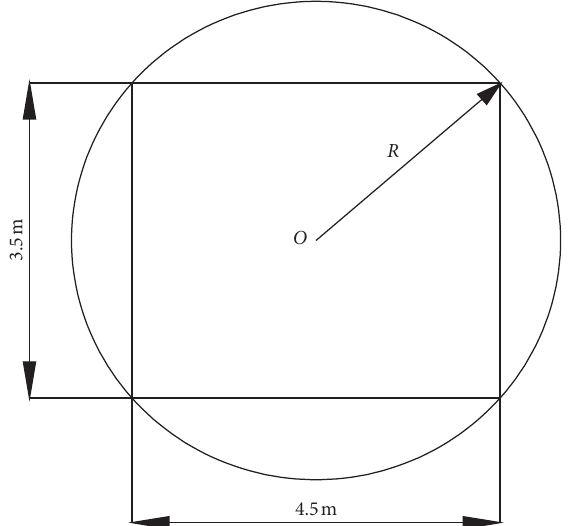
Figure 2: Equivalent roadway